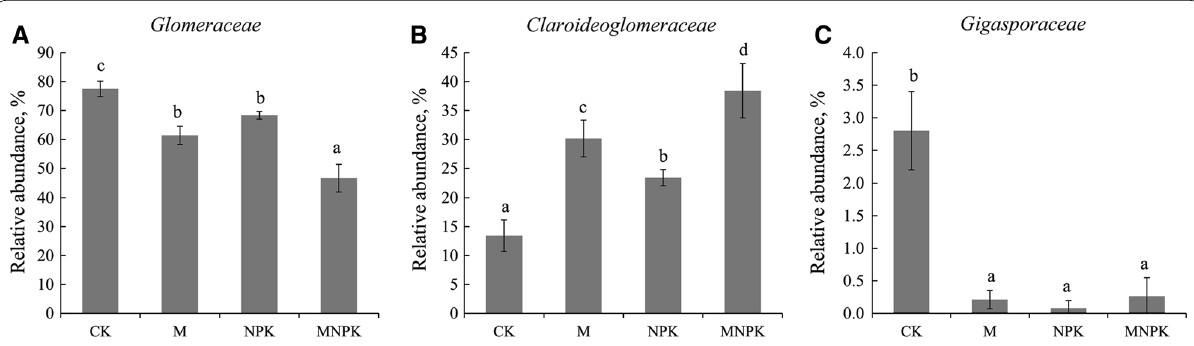
Fig. 1 Relative abundances of AMF at family level with significant differences among fertilization regimes. A Glomeraceae ; B Claroideoglomeraceae ; C Gigasporaceae . Error bars indicate the standard deviation of relative abundance between three replicate samples. Lowercases above columns indicate significant differences (P < 0.05, Tukey’s test)